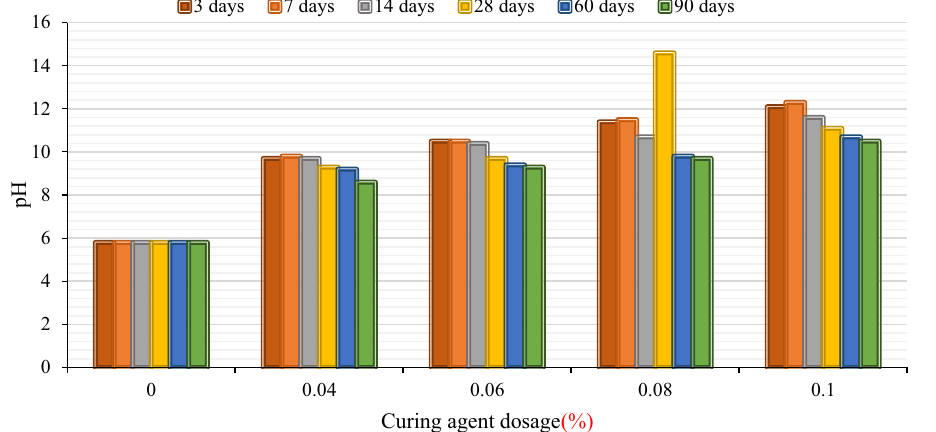
Figure 7. Test results of pH of BCP-stabilized soil.